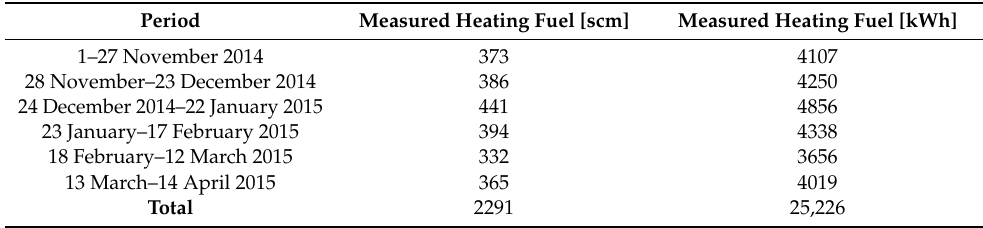
Table 2. Energy consumption data with conversion from scm to kWh.